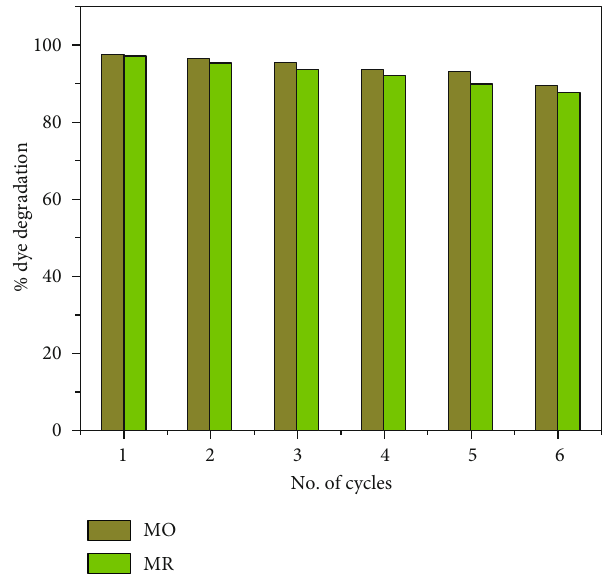
Figure 15: Photocatalytic activity of Fe catalysts on repeated